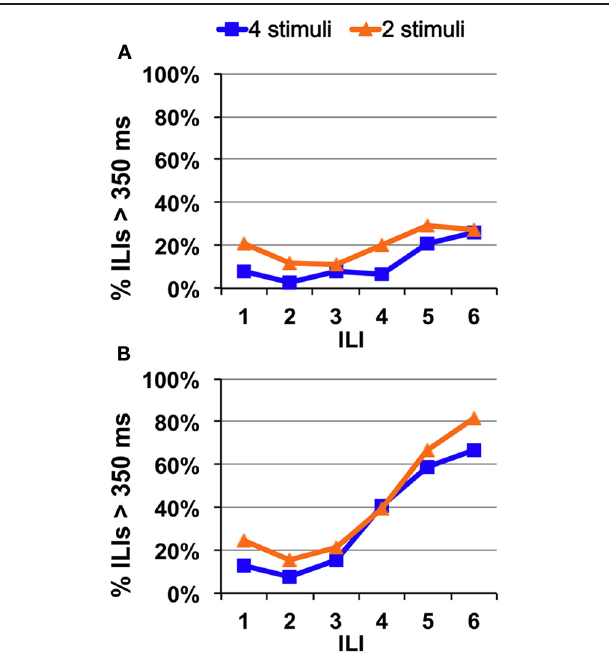
FIGURE 8 | Direct comparison of speed of quinine identification when two or four tastants are presented in a single session. Percentage of ILI’s above 350ms. All rats were untrained. (A) Quinine was presented at 0.1mM. (B) Quinine was presented at